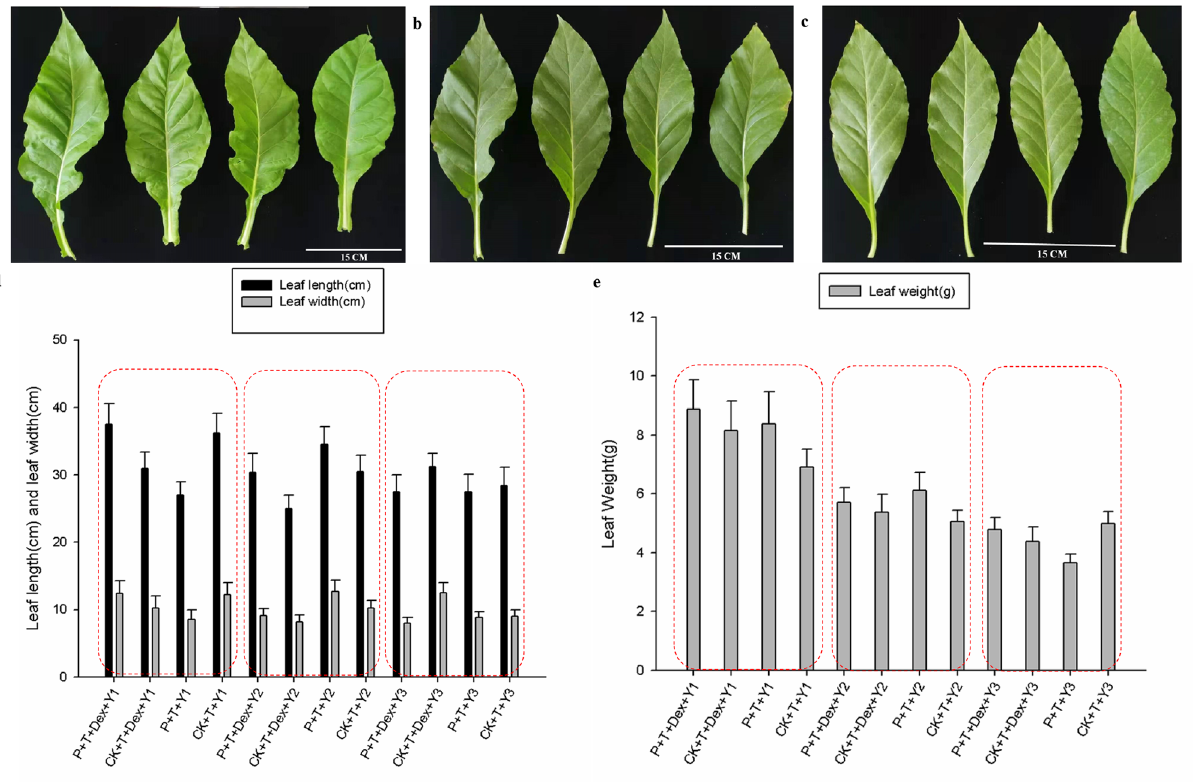
Figure 7. The leaf length, leaf width and leaf weight of the 1st, 2nd and 3rd leaves after topping of positive transgenic plants/control plants applied with/without 50 µM DEX. P: positive transgenic plants; T: topping; Dex: 50 µM dexamethasone; Y1: the 1st leaves of the application site; Y2: the 2nd leaves; Y3: the 3rd leaves. ( a ) Comparison of the 1st leaf after topping, from left to right: positive transgenic plants treated with 50 µM dexamethasone, positive transgenic plants treated with lanolin, control plants treated with 50 µM dexamethasone, control plants treated with lanolin; ( b ) comparison of the 2nd leaf after topping, from left to right: positive transgenic plants treated with 50 µM dexamethasone, positive transgenic plants treated with lanolin, control plants treated with 50 µM dexamethasone, control plants treated with lanolin; ( c ) comparison of the 3rd leaf after topping, from left to right: positive transgenic plants treated with 50 µM dexamethasone, positive transgenic plants treated with lanolin, control plants treated with 50 µM dexamethasone, control plants treated with lanolin; ( d ) comparison of the leaf length and leaf width of the 1st, 2nd and 3rd leaves after topping of positive transgenic plants/control plants applied with/without 50 µM DEX; ( e ): comparison of the leaf